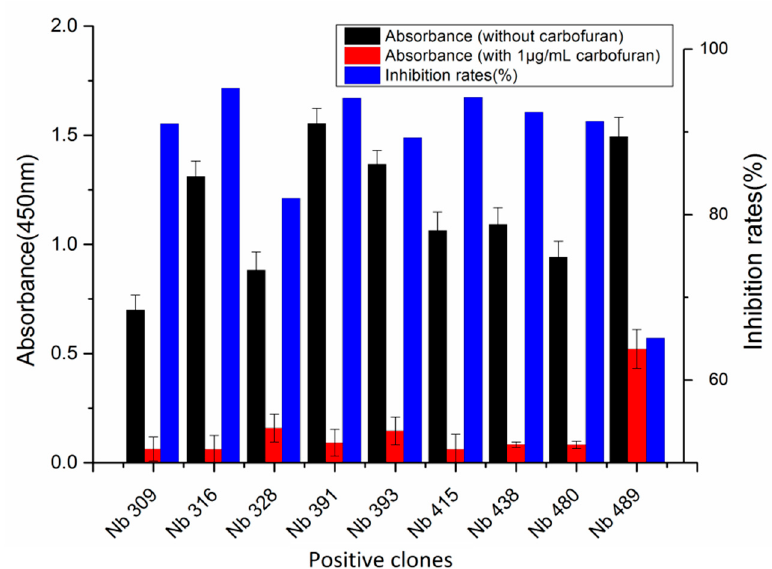
Figure 1. Nine phage clones binding to carbofuran selected and identified by ic-ELISA. Inhibition rate = (absorbance at 450 nm without carbofuran—absorbance at 450 nm with 1 µ g / mL carbofuran) / absorbance at 450 nm without carbofuran. Nb316 showed the highest inhibition rate for carbofuran.